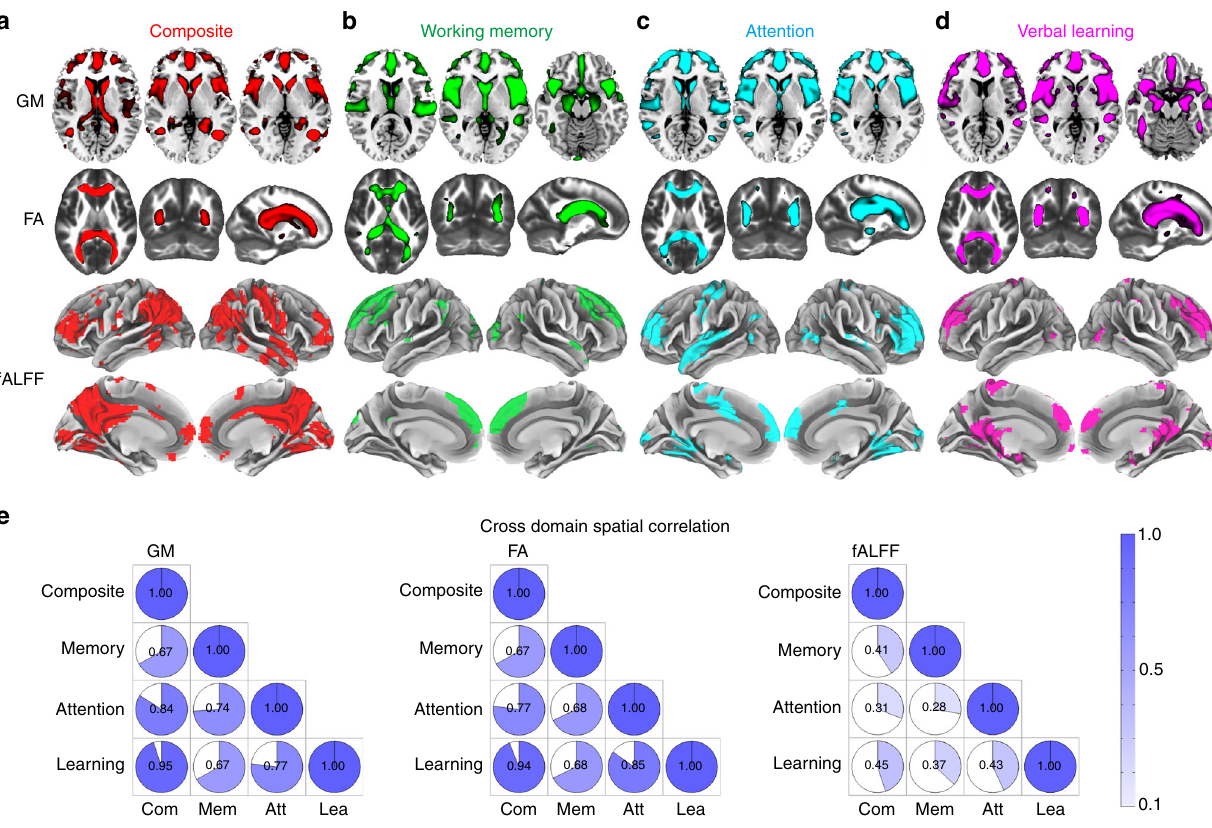
Fig. 5 Comparison of multimodal components associated with the four speci fi c cognitive domains. The spatial maps of the neuromarker network obtained under the guidance of reference a composite score (red), b working memory (green), c attention (cyan) and d verbal learning (magenta) are displayed in different color mapping. e The pairwise, cross-domain, spatial correlation among brain maps of FBIRN_IC ref_composite , FBIRN_IC ref_memory , FBIRN_IC ref_attention , and FBIRN_IC ref_learning for GM, FA and fALFF respectively. The darker blue and larger shading denotes higher correlation. Note that GM and FA maps demonstrate more consistent patterns across cognitive domains ( r > 0.6), while fALFF maps exhibit more variance ( r < 0.5 but still signi fi cant). This suggests that a functional measure such as fALFF may differentiate between cognitive domains more sensitively, whereas structural